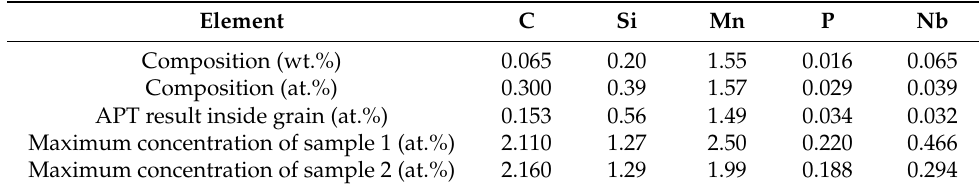
Table 1. Chemical comparison of X70 steel and the three-dimensional atom probe (3DAP) result in a grain.